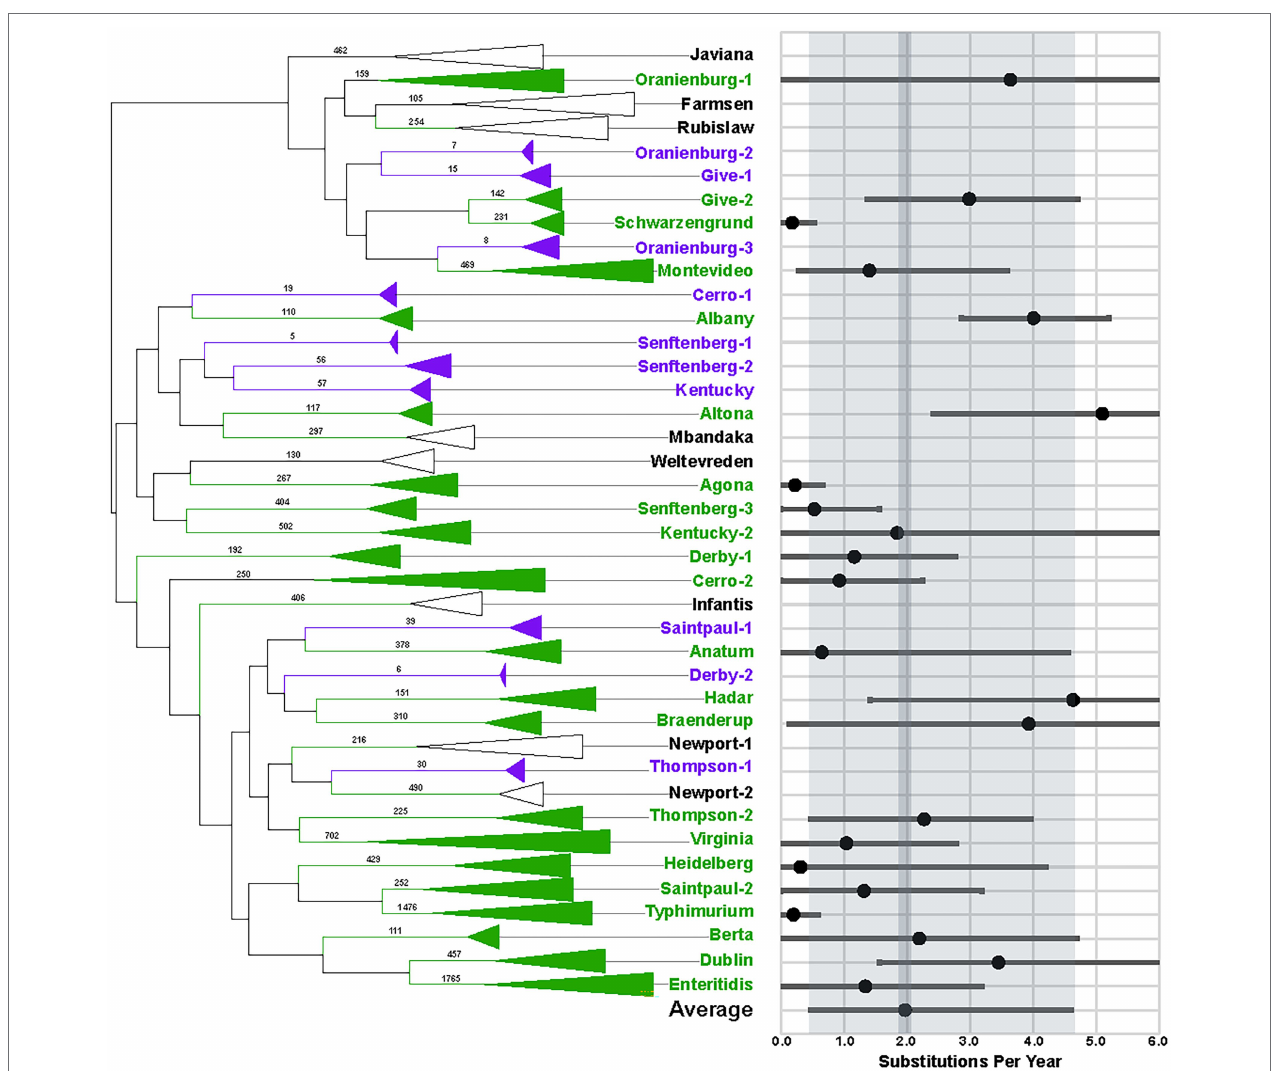
FIGURE 1 | Phylogeny and evolutionary rate measurements of 29 Salmonella enterica serotypes. Values on branches of the phylogenetic tree indicate the numbers of taxa that comprise each clade. Green labels indicate that ≥ 100 taxa were available for evolutionary analyses, while purple labels show clades with < 100 taxa that were not analyzed. Clades that have ≥ 100 taxa but did not exhibit clock-like behavior are labeled with black. Results of BEAST analyses are indicated in the graph with black dots. Bars indicate 95% HPD values. Gray shading shows the averages of